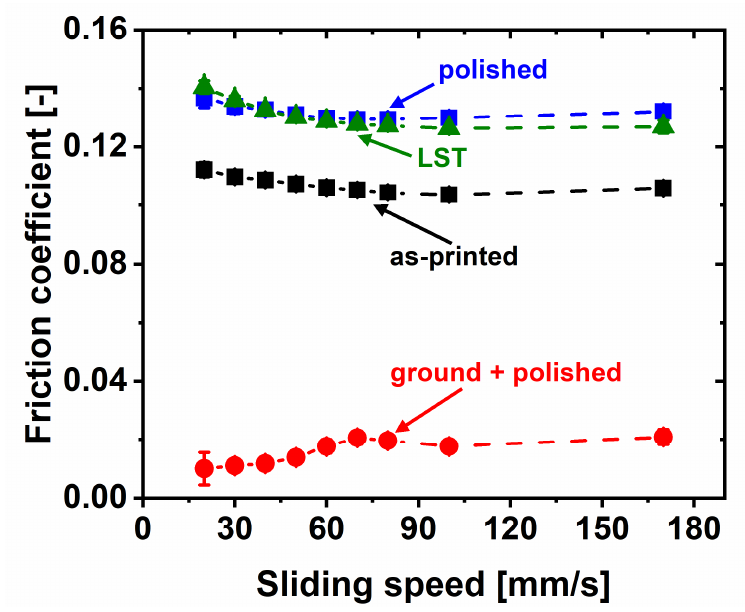
Figure 3. Average friction coefficient as function of sliding speed for as-printed, polished, ground and polished, and laser-surface-textured samples. Experiments were performed in a pin-on-disk fashion against 100Cr6 bearing steel disks. Sliding speed was varied between 20 and 170 mm/s, and ramps were repeated five times. Results are the average of these five ramps deduced from two independent experiments. For most data points, error bars representing standard deviation are smaller than the size of the symbols. Normal force was 10 N. FVA2 unadditivated mineral oil was used to lubricate the contact.